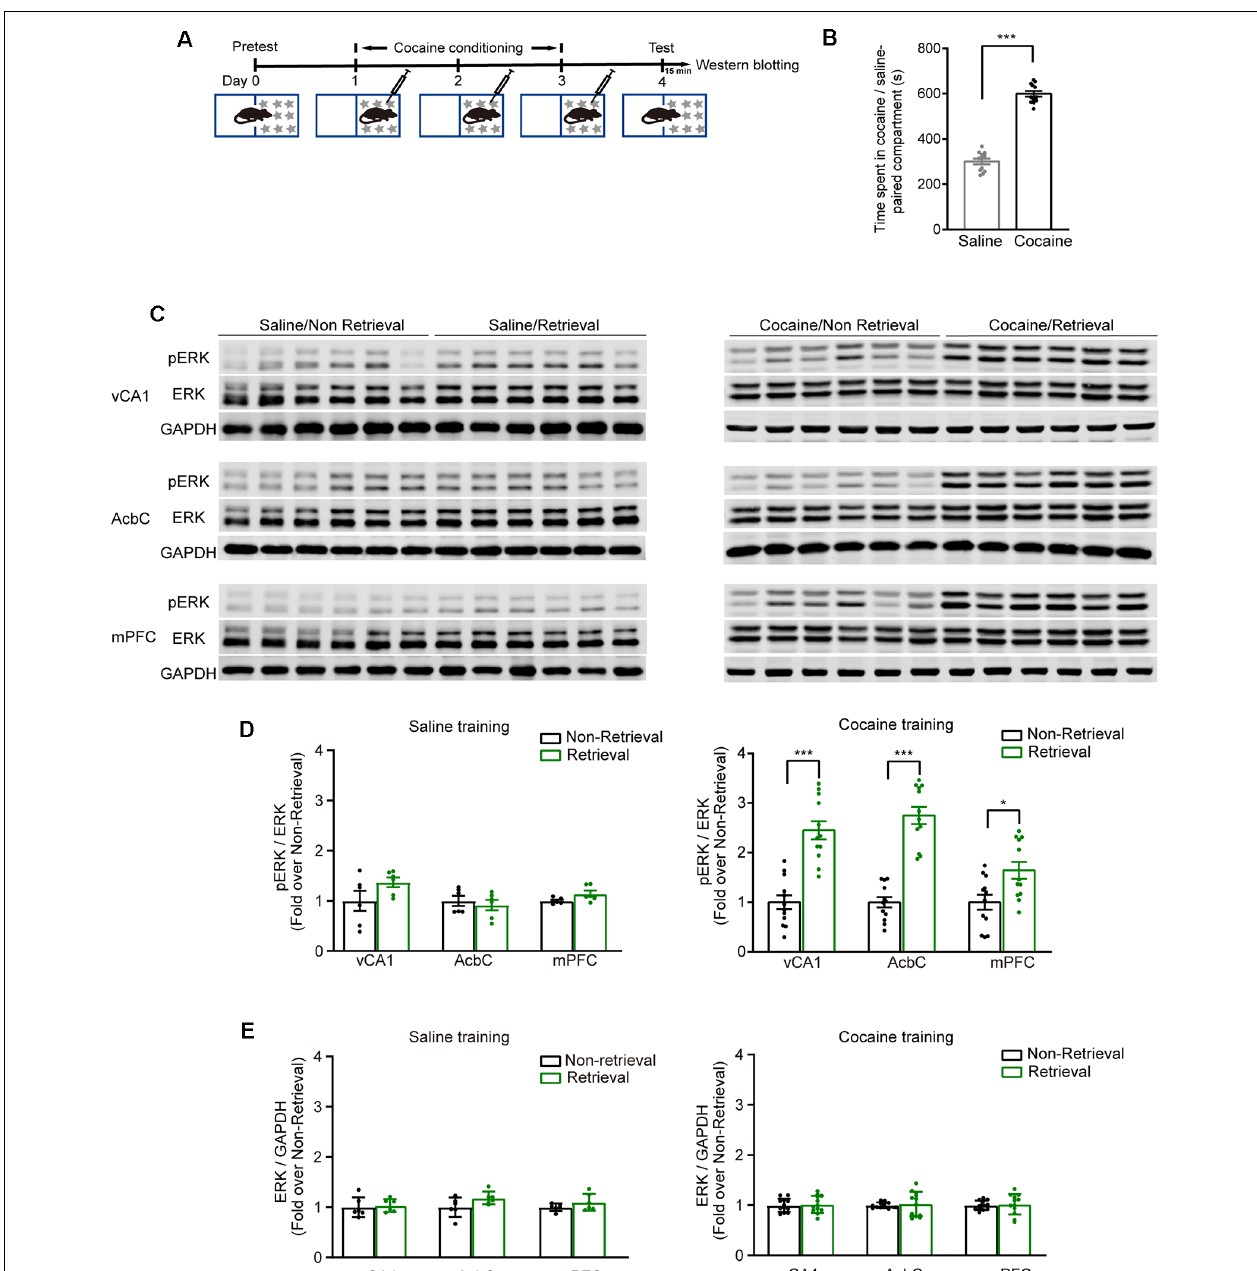
FIGURE 1 | The expression levels of pERK increased in the vCA1, AcbC, and medial prefrontal cortex (mPFC) after retrieval of cocaine-conditioned place preference (CPP) memory. (A) Experiment scheme. At 24 h after cocaine conditioning, memory retention test was performed. The mice of the retrieval group were subjected to the memory retention test and re-exposed to the CPP apparatus. The mice of the non-retrieval group remained in their home cage. Brain tissue was collected 15 min after memory retrieval for Western blotting. (B) Bar graph representing the time spent in the cocaine-paired and the saline-paired compartments of the retrieval group in the memory retention test. *** P < 0.001 vs. saline-paired compartment. (C) Representative images of pERK expression. (D) Quantification of pERK levels in brain regions as indicated. (E) Quantification of ERK levels in brain regions as indicated. * P < 0.05, *** P < 0.001 vs. the non-retrieval group (saline conditioning groups: n = 6; cocaine conditioning groups: n = 12).